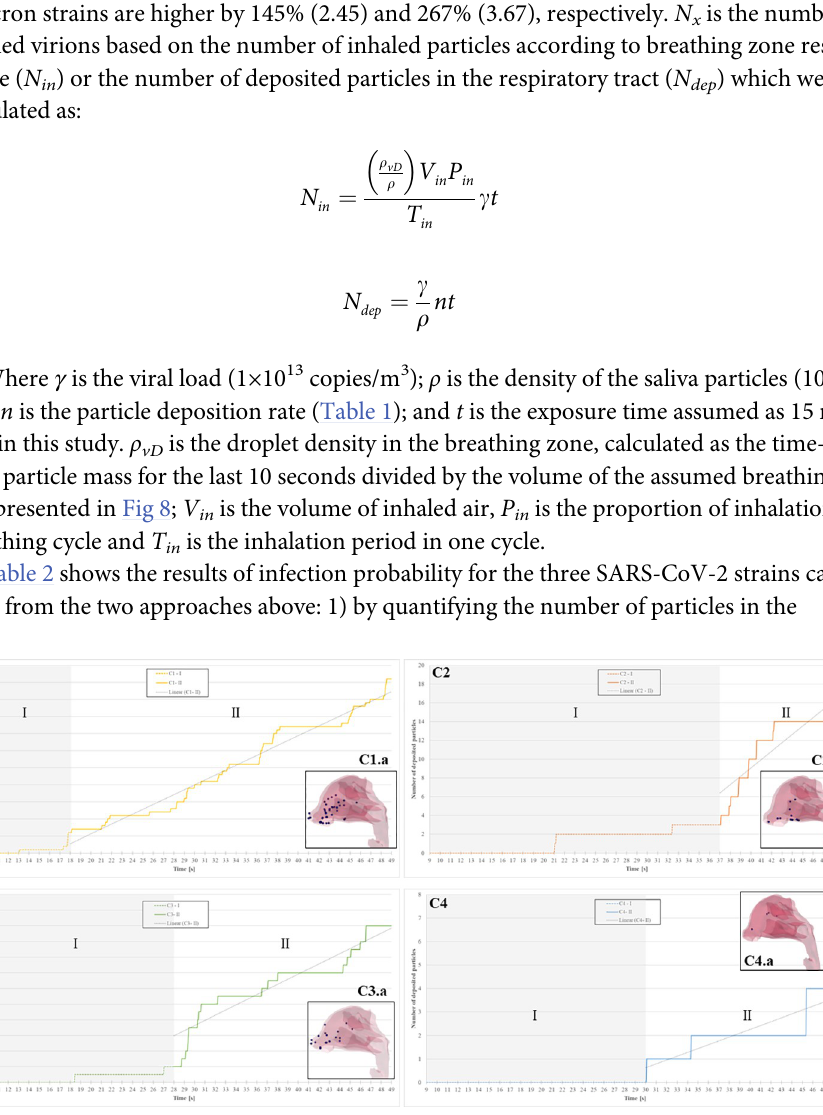
Fig 9. Evolution of particle deposition in the nasal vestibule and nasal cavity and depiction of total number of particles deposited in the respiratory tract.